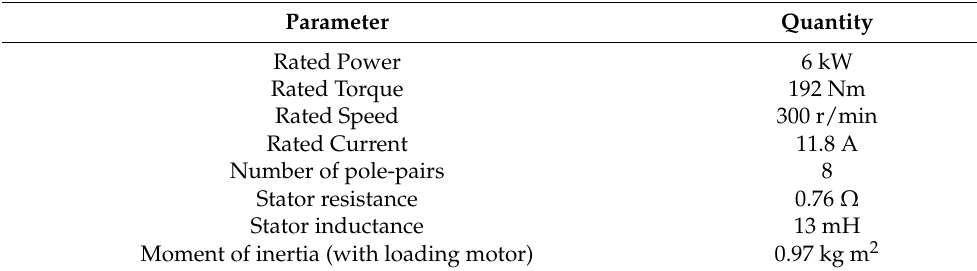
Moment of inertia (with loading motor)